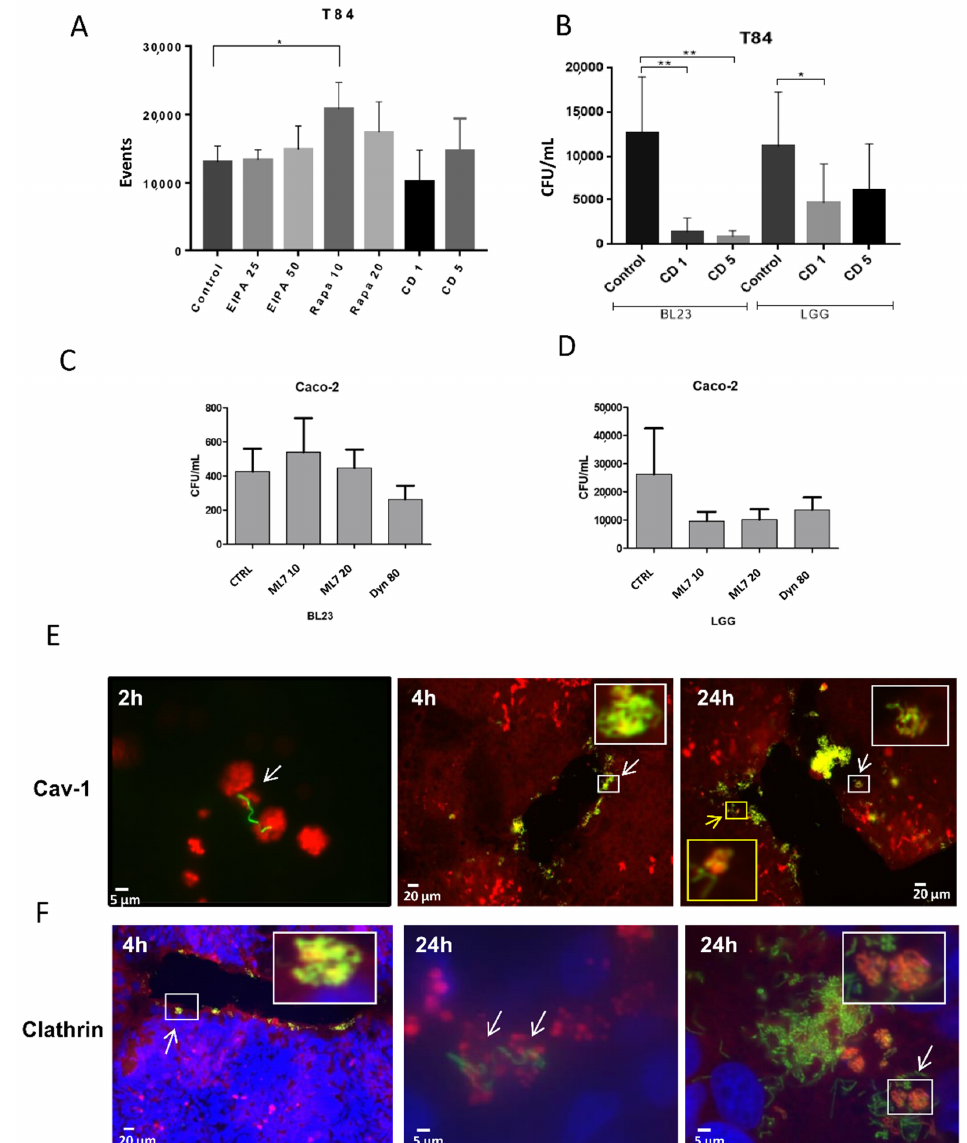
Figure 4. Bacterial uptake inhibition by different specific drugs and co-localization with clathrin and caveolin. Internalization was determined by ( A ) flow cytometry and ( B – D ) gentamicin protection assays. ( A ) Relative number of events found by flow cytometry after co-incubation of T84 with BL23 [pT1-GR::p127], treated with EIPA, rapamycin and cytochalasin D at the indicated concentrations. ( B ) Internalization assay of BL23 and LGG after gentamicin protection assay of T84 incubated with cytochalasin D. ( C ) Internalization of BL23 in Caco-2 cells treated with ML7 and dynasore at the indicated concentrations. ( D ) Internalization of LGG in Caco-2, same as ( C ). The experiments were performed with five replicates in triplicate and the differences between the groups compared with the Bonferroni and Tamhane tests, * p ≤ 0.05; ** p < 0.001. ( E ) Figures represent immune co-localization caveolin-1 with BL23 [pT1-GR::127] in cell line T84 at different times (2, 4 and 24 h). The blue channel revealing DAPI stained nuclei was deselected because the presence of blue fluorescence hampered the definition of caveolin-1 vesicles. The white scale bar represents 5 µ m or 20 µ m as indicated. ( F ) Figures represent immune co-localization clathrin with BL23 [pT1-GR::127] in cell line T84 at different times (4 and 24 h). In ( E , F ) bacteria are observed in green (GFP), conjugated anti-caveolin-1 and anti-clathrin are labelled in red (AlexaFluor594) and nuclei are observed in blue by DAPI. The white scale bar represents 5 µ m or 20 µ m as